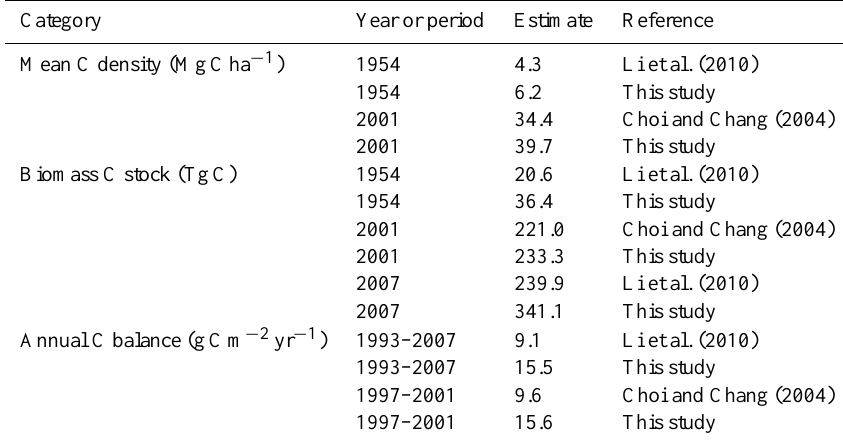
Table 2. Comparison of biomass carbon (C) density, biomass C stocks, and annual C balance rate of South Korean forests with those of two previous studies.